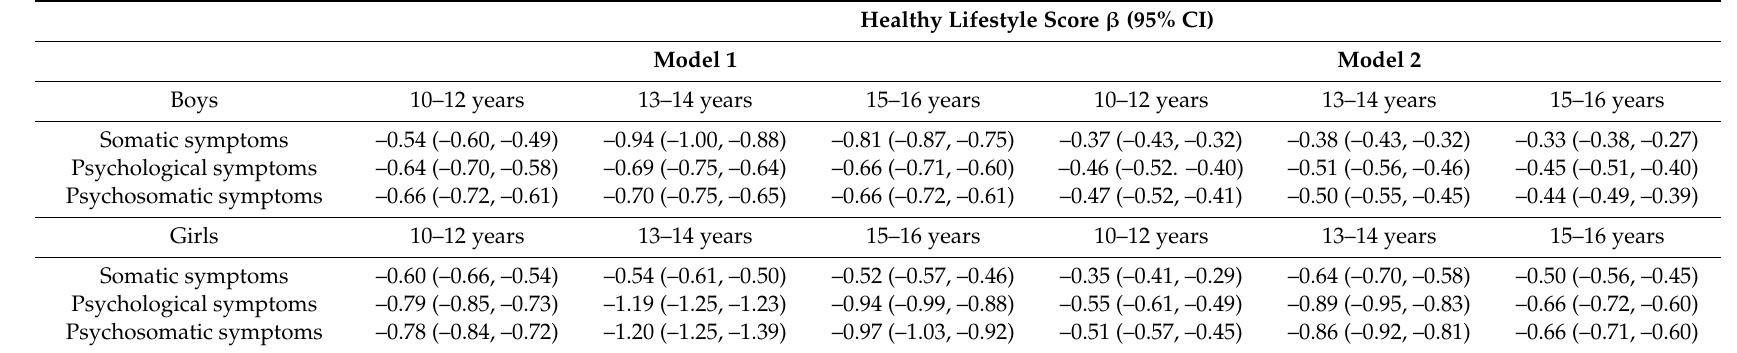
Table 4. Relationship between healthy lifestyle score and psychosomatic